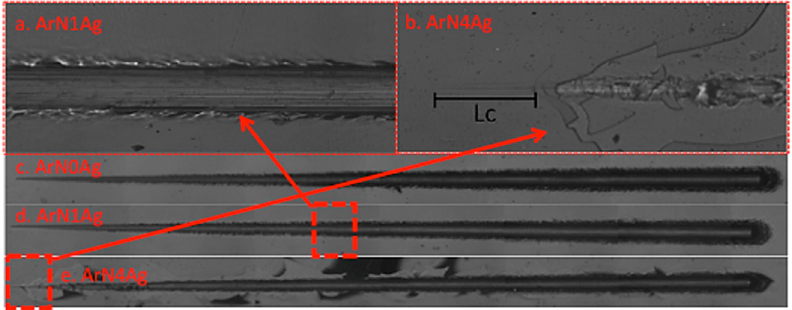
Figure 6. Micrographs of the wear track produced by the scratch tester in coatings deposited in a reactive atmosphere: ( a , d ) ArN1Ag; ( b , e ) ArN4Ag; ( c ) ArN0Ag.